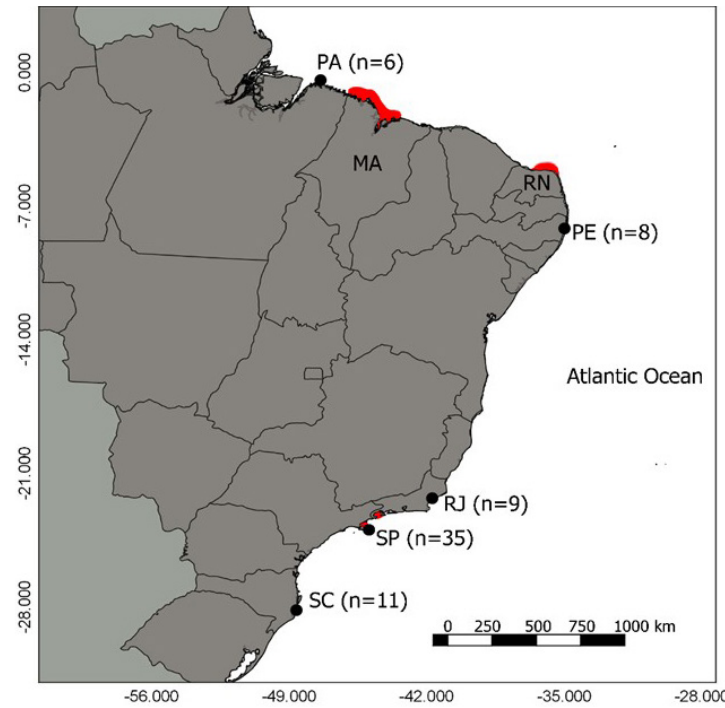
FIGURE 1 | Map of sampling sites of Rhinoptera bonasus in the Brazilian coast. South Western Atlantic region, from Amazonic ecoregion (Pará – PA), Northeastern ecoregion (Pernambuco – PE), and Southeastern ecoregion (Rio de Janeiro – RJ, São Paulo – SP and Santa Catarina – SC). Numbers in parenthesis indicate number of samples. Red markers illustrate nursery regions described for rays species (Yokota, Lessa, 2006; Feitosa et al ., 2017; Rangel et al ., 2018; Silva, Vianna,